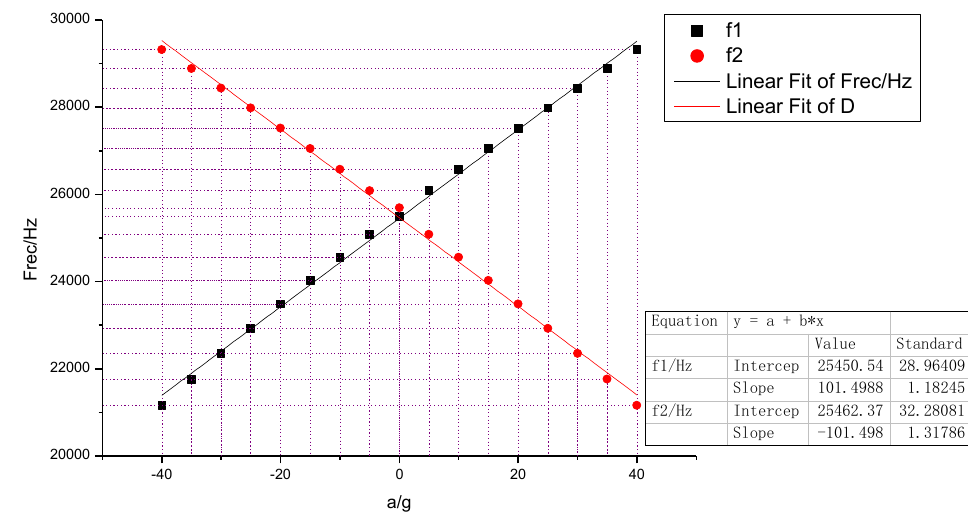
Figure 8. Simulated resonant frequency output versus the input acceleration. Table 4. Simulated and testing results of the SMRA.